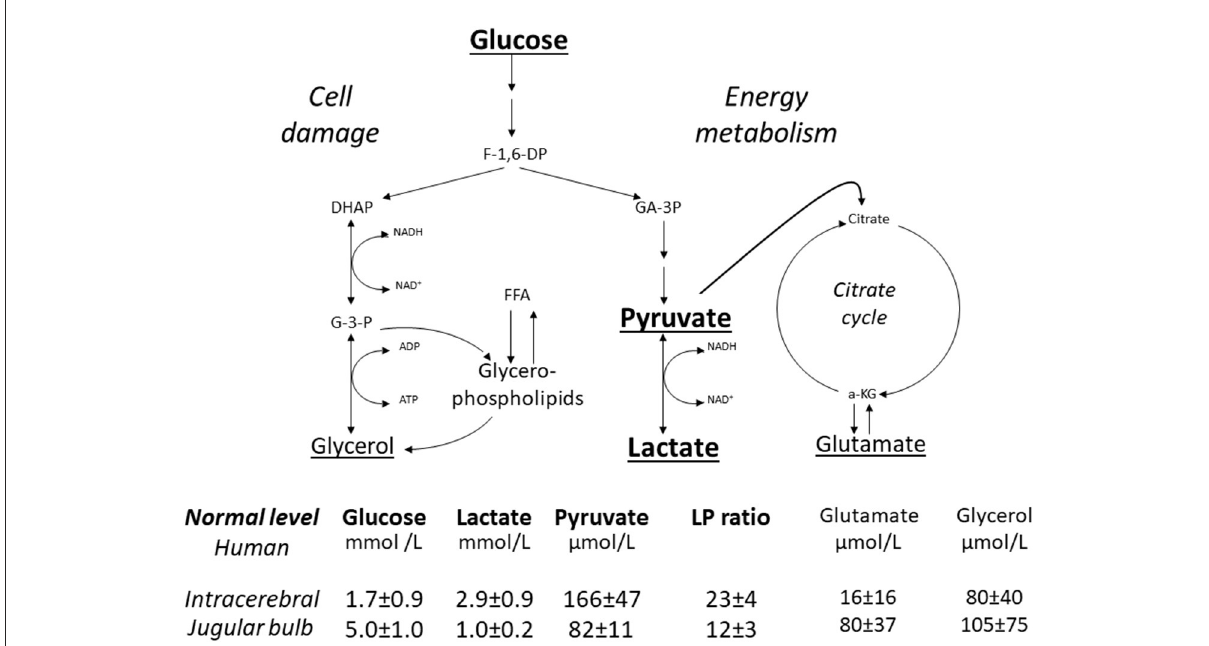
FIGURE2 Schematic diagram of cerebral intermediary metabolism, with a focus on the glycolytic chain (glucose, pyruvate, lactate) and its relation to glycerol and glycerophospholipids and to the citric acid cycle (Krebs cycle). F-1,6-DP, fructose-1,6-diposphate; DHAP, dihydroxyacetone-phosphate; GA-3P, glyceraldehyde-3-phosphate; G-3-P, glycerol-3-phosphate; FFA, free fatty acids; α -KG, α -ketoglutarate. Underlined metabolites are measured bedside with enzymatic techniques. References levels of the various metabolites for normal human brain obtained from (42). Reference levels for jugular venous blood obtained from (43). Reference values are given as Mean ± SD.